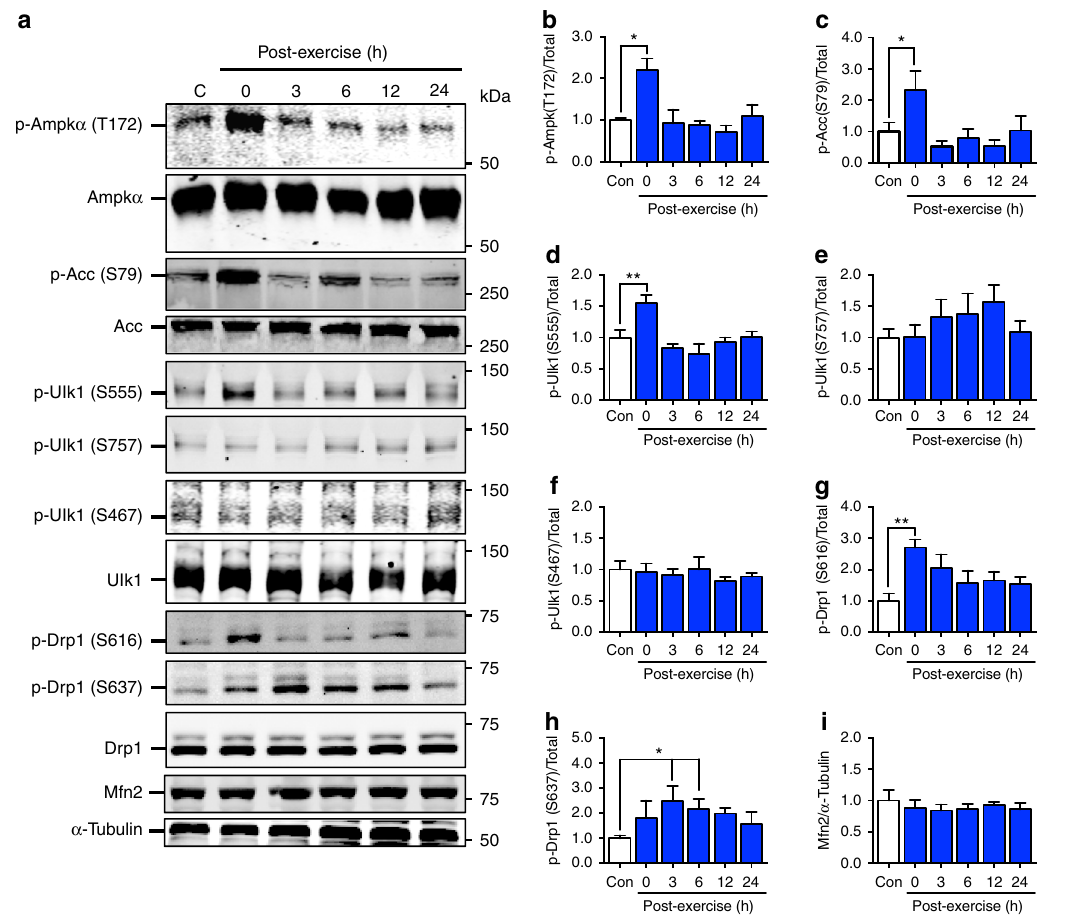
Fig. 2 Ampk, Ulk1 and Drp1, are transiently activated immediately following acute exercise. Ampk and its substrate Acc are phosphorylated at Thr172 a , b and S79 a , c , respectively, immediately after the cessation of exercise and return to baseline values by 3 h post-exercise in C57BL/6 J mice aged 10 – 12 weeks. Ulk1 is phosphorylated at Ser555, but not Ser467 or Ser757, immediately following acute exercise, which returns to basal levels by 3 h post- exercise a , d – f . Drp1 is phosphorylated in skeletal muscle at Ser616 a , g immediately after the cessation of exercise and Ser637 a , h reaching signi fi cance 3 and 6 h after exercise. Mfn2 protein abundance is unchanged following acute treadmill running a , i . Representative western blots are shown a and all quanti fi cation is presented as protein phosphorylation to total protein abundance ratio b – f . Data presented as mean ± standard error of the mean. n = 5 (except 24 h, n = 4). See also Supplementary Figs. 6 and 7. Results of one-way ANOVAs are * p < 0.05, ** p < 0.01. F = 6.44 for b , F = 3.56 for c , F = 6.50 for d , F = 0.89 for e , F = 0.33 for f , F = 3.34 for g , F = 2.76 for h , F = 0.31 i . DF = 5. p-Ampk (T172/Total) b was sqrt transformed to account for unequal variance., DF = 5. S637/total Drp1 data was log transformed to account for unequal green ratio or number of pure red puncta in the contralateral FDB Fig. 3A, D), as well as voltage dependent anion channel (Vdac)